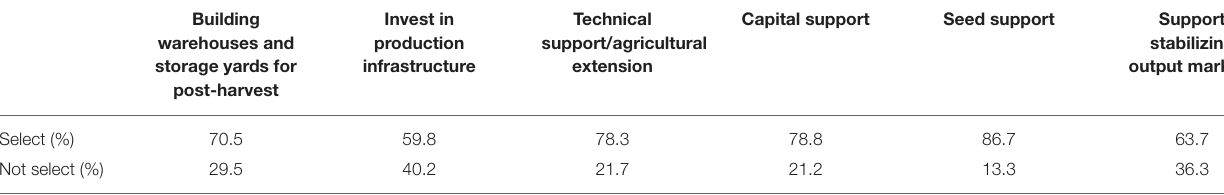
TABLE 7 | Choice of local people on solutions to respond to climate change/natural